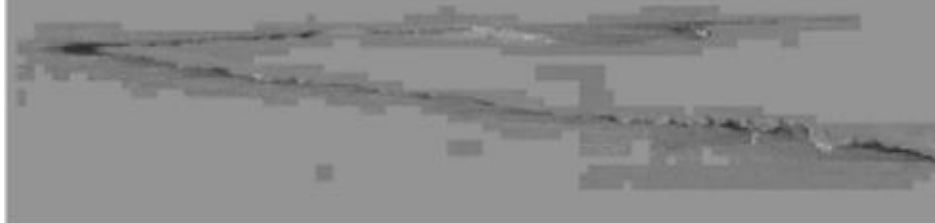
Figure 7. A partially subsurface sliver. Processed in Ametek [30].